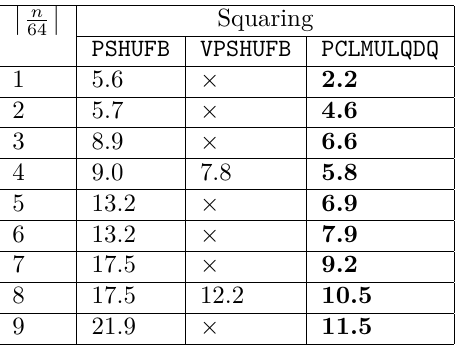
Table 5: Number of cycles for computing the square of an element of F 2 [ X ] of degree n − 1, with MQsoft . We use a Skylake processor